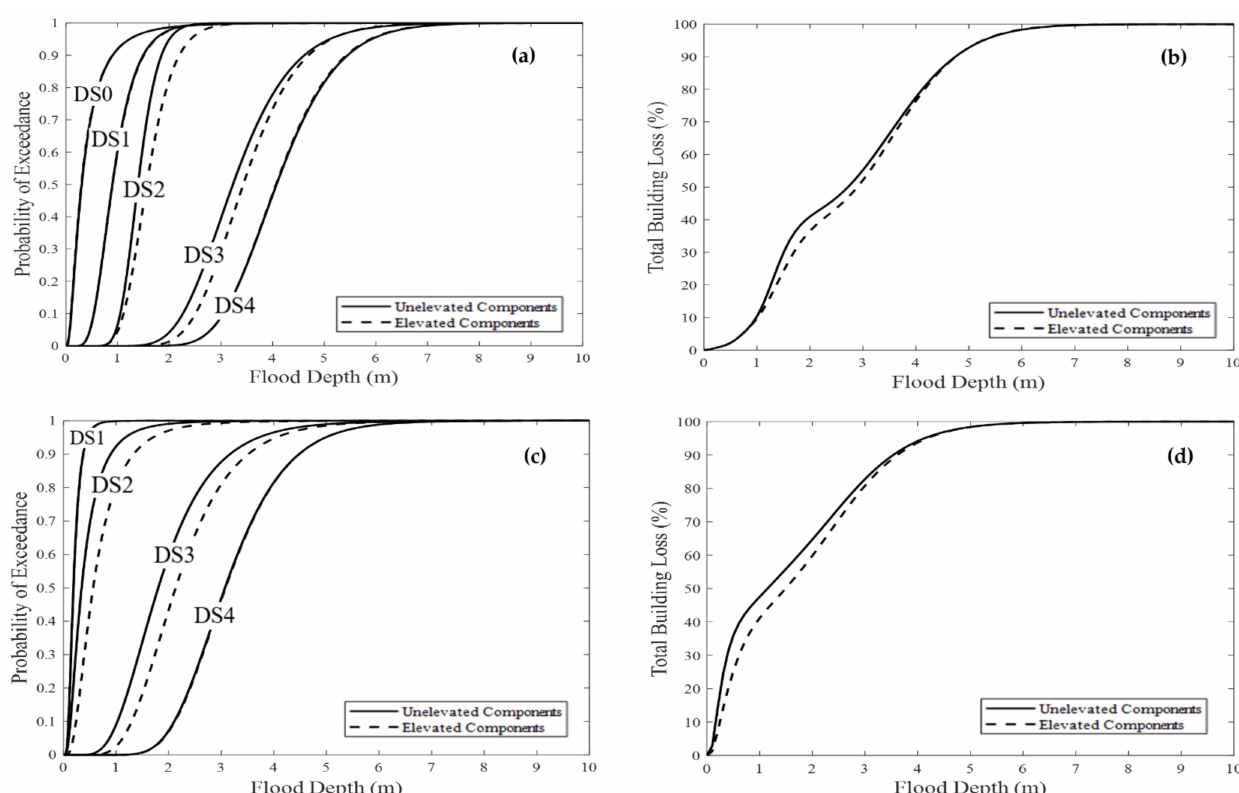
Figure 5. The fragility and loss functions based elevated and unelevated components for: ( a , b ) Archetype F1; ( c , d ) Archetype F2,